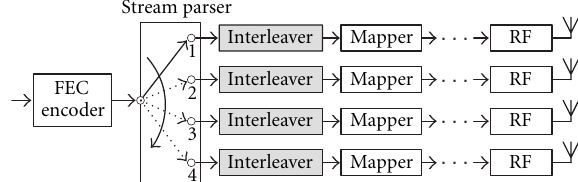
Figure 8: Use of interleaver in multiple spatial streams